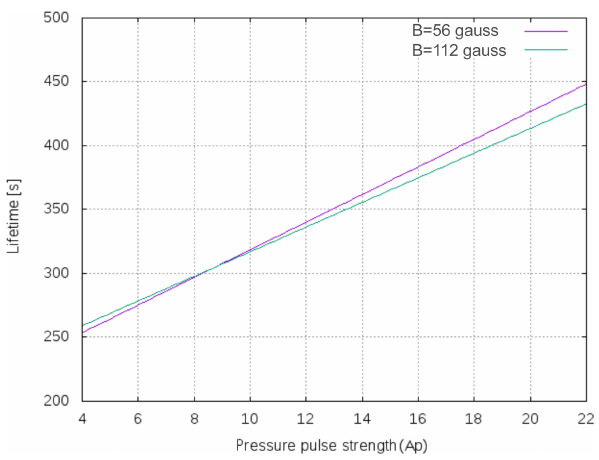
Figure 11. Lifetime of the model jets vs. pressure pulse